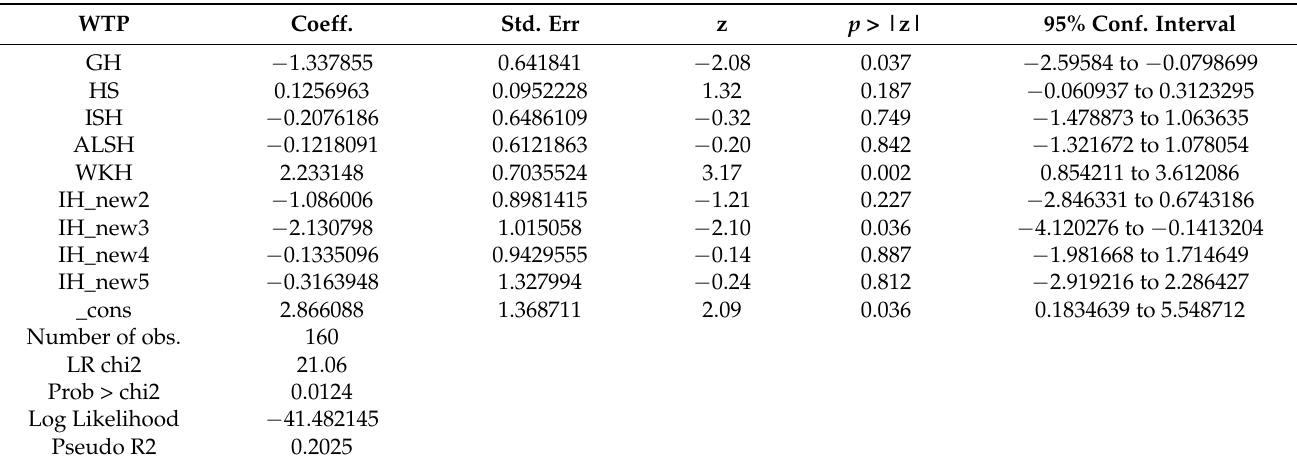
Table 5. Results of ordered logistic regression on determinants of the WTP nested model